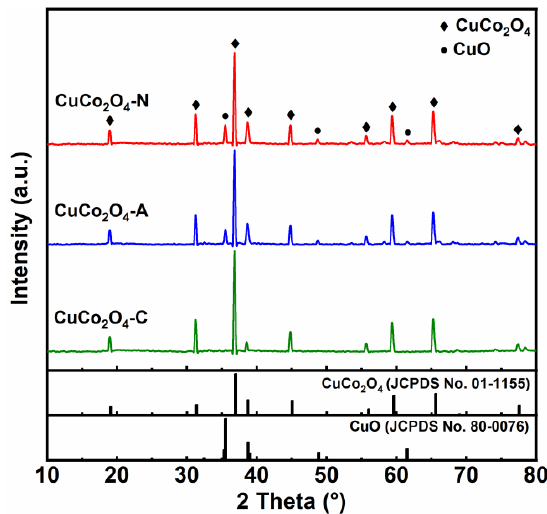
Figure 2. XRD patterns of the CuCo 2 O 4 - x ( x = N, A and C) catalysts. Figure 3 shows the representative SEM images of the CuCo 2 O 4 - x ( x = N, A and C) catalysts. The CuCo 2 O 4 -N catalyst exhibits a sheetlike morphology with tiny spherical particles on its surface. The stacking of spherical particles and its sheetlike morphologies promote the formation of porous structures (Figure 3a). The phenomenon of particle agglomeration is exhibited over the CuCo 2 O 4 -A and CuCo 2 O 4 -C catalyst (Figure 3c,e). As shown in Figure 3b, the spherical particles are dispersed on the sheetlike morphology and formed a dendritic structure. However, tiny spherical particles are hardly generated on the surfaces of the CuCo 2 O 4 -A and CuCo 2 O 4 -C catalysts (Figure 3d,f), while the agglomeration of bulk particles might have resulted in the blockage of the pore systems. These tiny spherical particles can improve the contact between the catalyst and soot particles, which can facilitate the utilization of the catalyst active sites for catalytic soot combustion. The particle sizes of CuCo 2 O 4 -A and CuCo 2 O 4 -C catalysts increased obviously compared to the CuCo 2 O 4 -N catalysts.